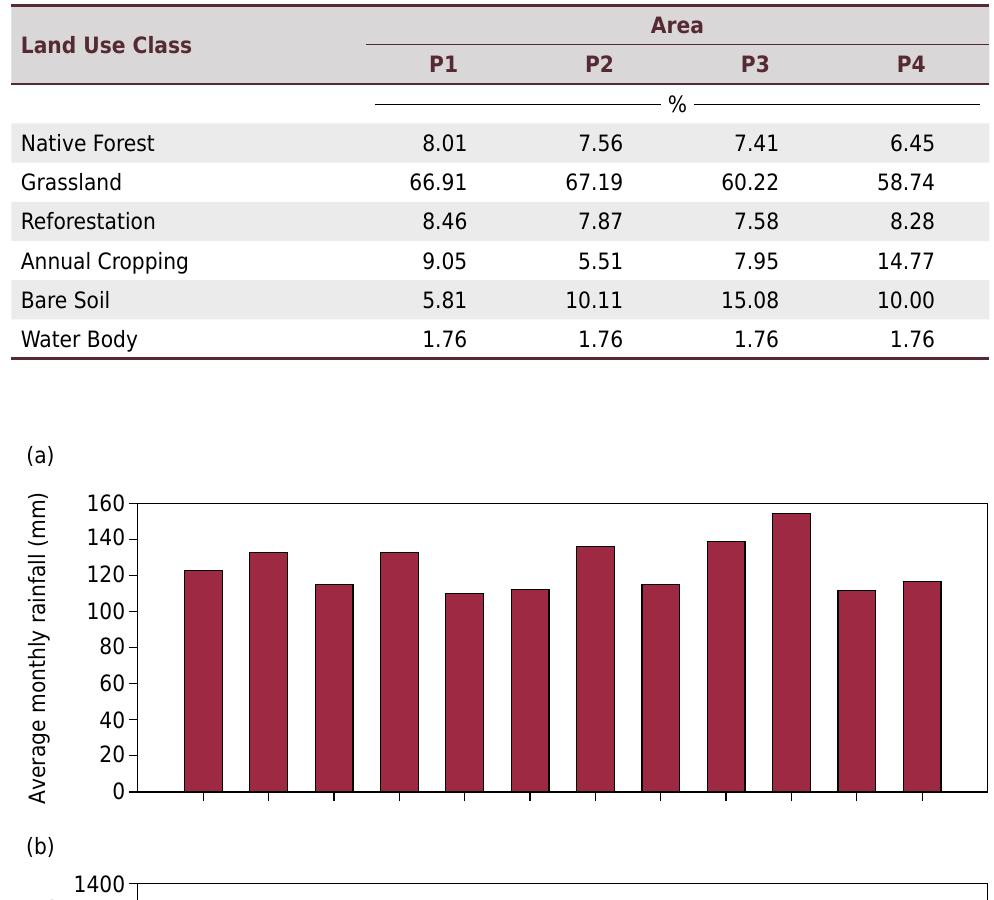
Table 2. Average values of the land use class in the